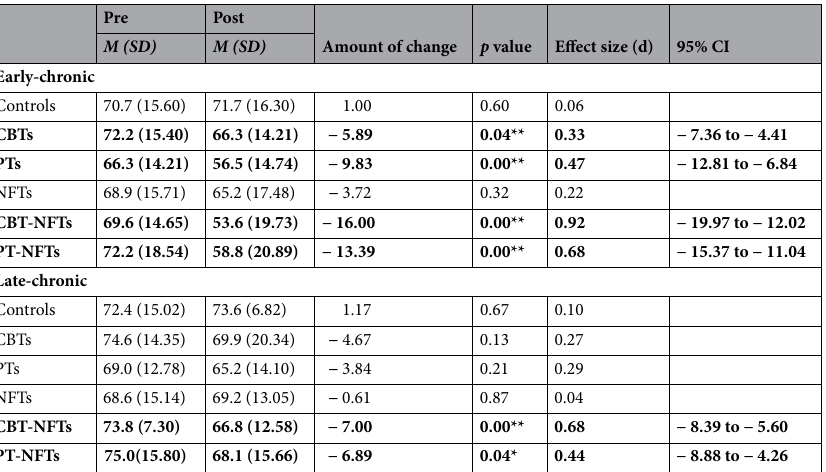
Table 3. Average difference in VAS values before/after the each interventions. Significant values are in [bold]. * p < 0.05. ** p < 0.01.